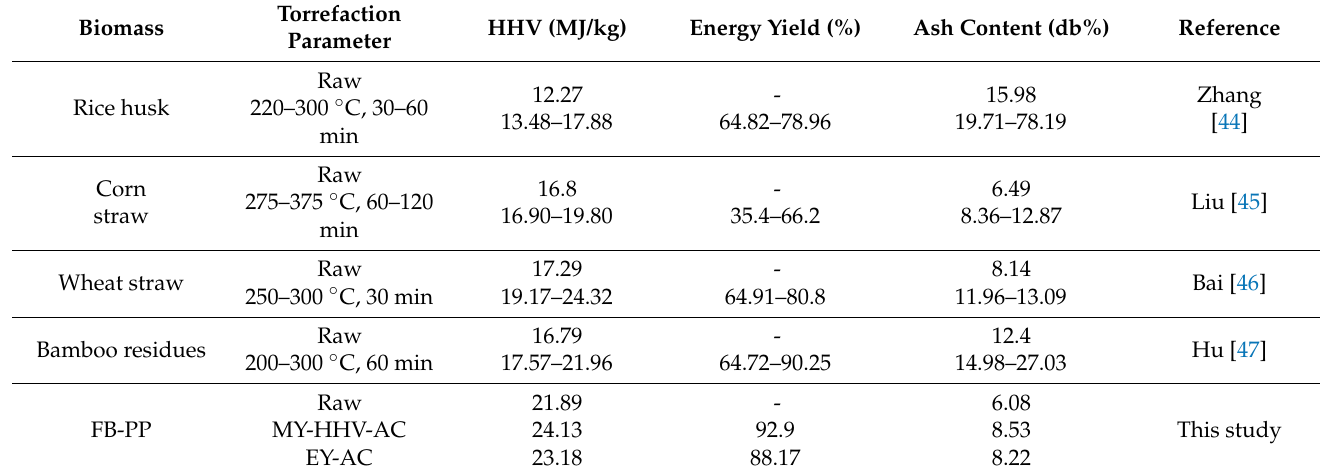
Table 6. Comparison of various types of biomass waste.